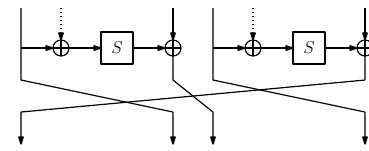
Figure 9: 4-GFS. Dotted lines denote (random) round keys.